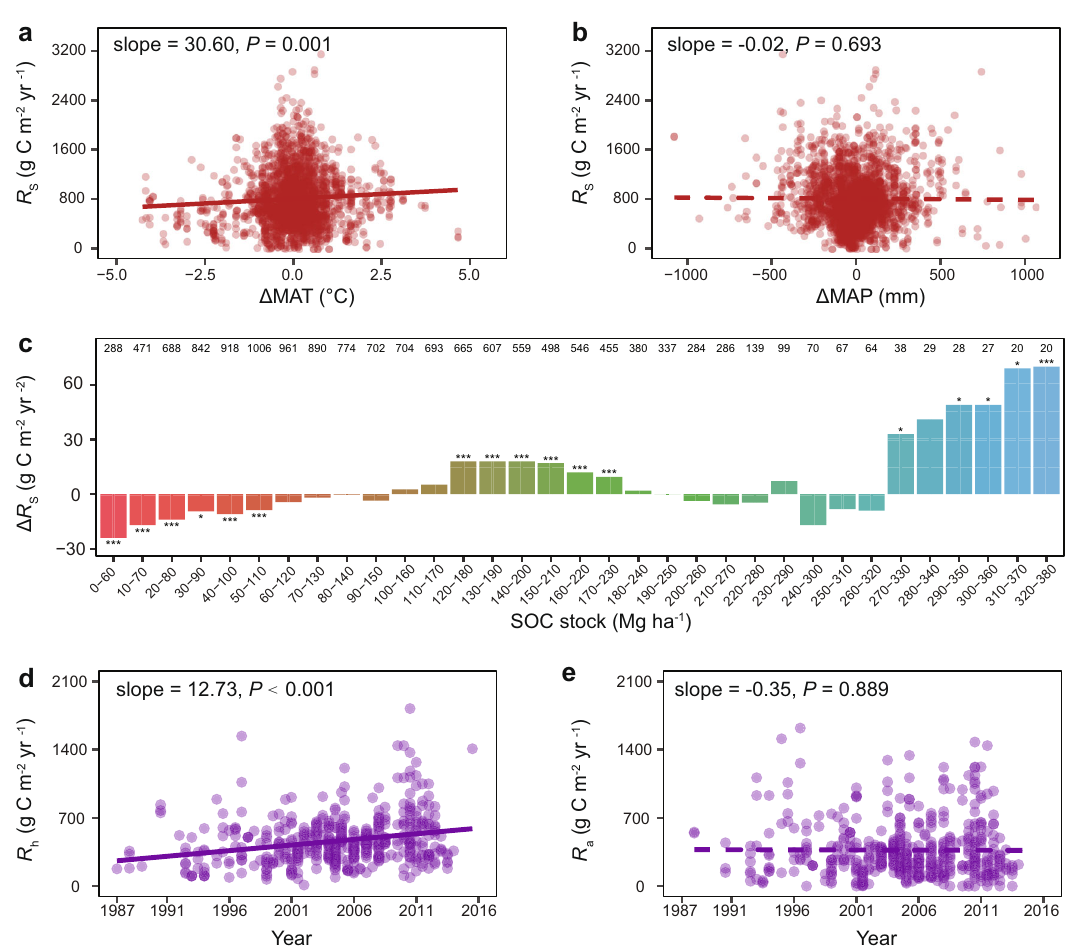
Fig. 3 Covariates of R S changes. a , b The relationship between R S and temperature anomaly ( Δ MAT) ( a ) and precipitation anomaly ( Δ MAP) ( b ). c The moving subset window analysis of R S changes in different SOC stock levels. Each window includes a subset of R S data whose SOC stocks are within a range of 60 Mgha – 1 and moves forward by 10 Mg ha – 1 step. The bars represent the rates of R S changes in different ranges of SOC stocks calculated as average annual R S change ( Δ R S ) in 1987 – 2016. The number above each bar refers to the number of R S records belonging to the subset window. *** P < 0.001, ** P < 0.010, * P < 0.050. d , e Temporal trends of global R h ( d ) and R a ( e ) in 1987 – 2016. The slope of linear regression indicates the rate of changes of R h or R a . The dot density represents data density at each point. Solid lines indicate signi fi cant trends ( P < 0.050), while dashed lines indicate insigni fi cant trends ( P ≥